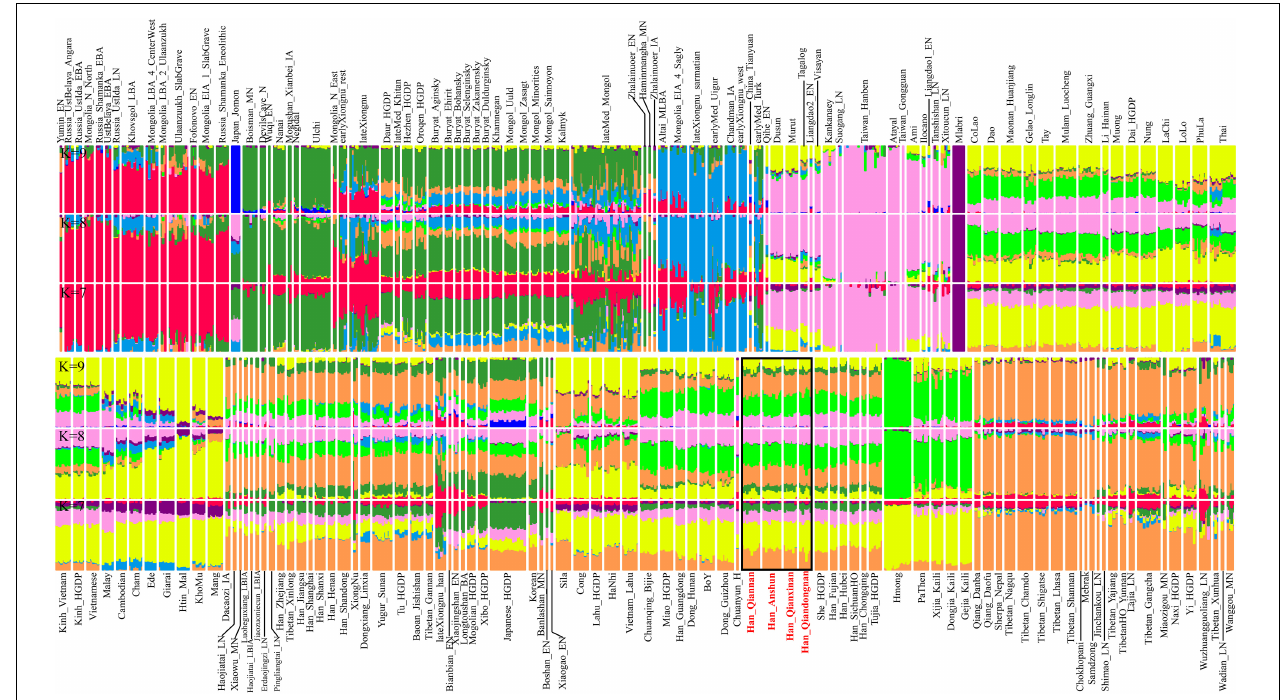
FIGURE 2 | Model-based analysis result among 1,471 individuals in 179 eastern Eurasian populations. The visualized plots used the ancestry coefficient when seven to nine ancestral sources were predefined.